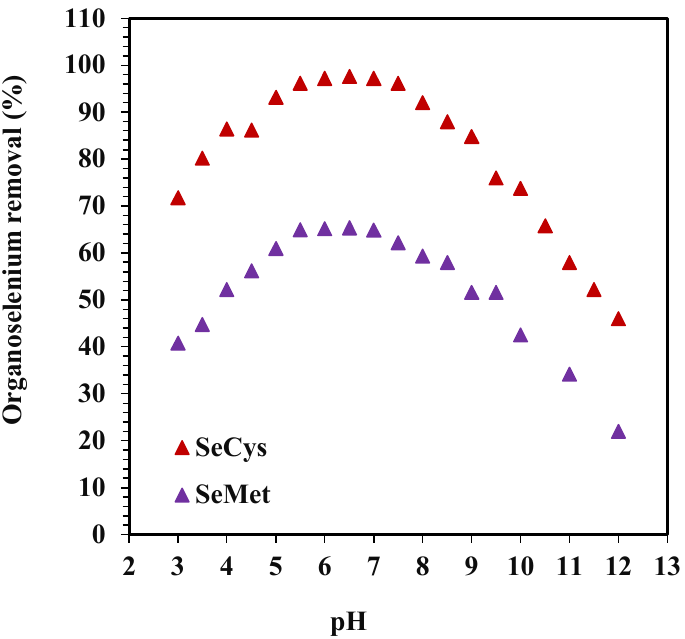
Figure 6. Adsorption envelopes of SeMet and SeCys on nZVI/GAC at initial organoselenium concentration of 0.5 mg/L and adsorbent ratio of 3 g/L. Contact time: 24 h at 25 °C.